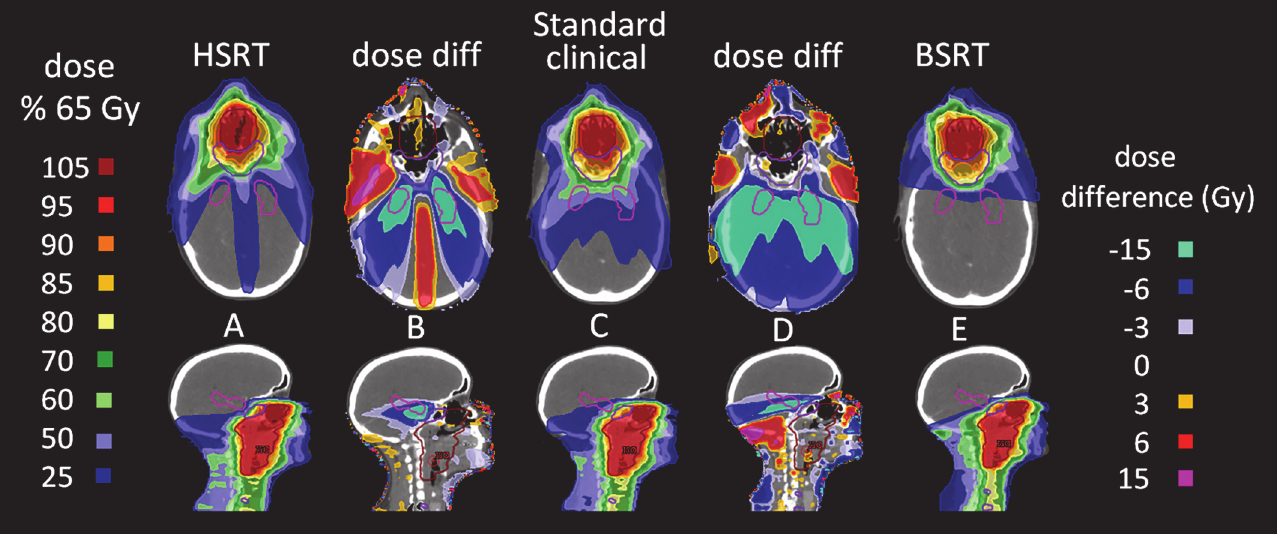
Fig 4. Treatment plans and dose difference maps. (A), (C), and (E) display axial (top) and sagittal (bottom) slices of typical HSRT, standard clinical, and BSRT treatment plans, respectively. (B) and (D) show dose difference maps between (A) and (C), and (E) and (C), respectively.